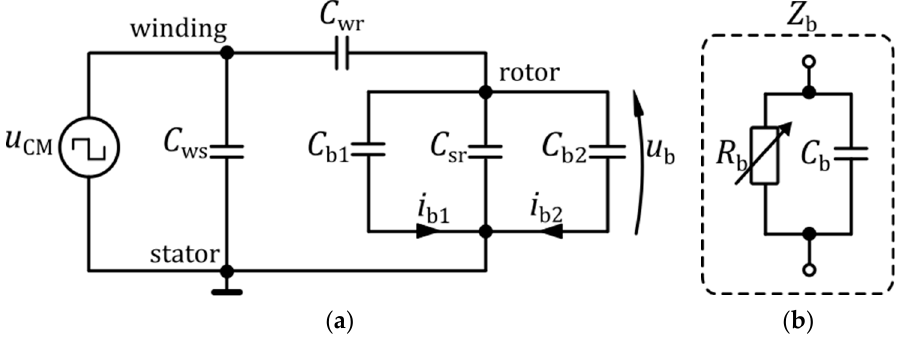
Figure 6. ( a ) Equivalent circuit diagram for the flow of the bearing current; u CM —common-mode voltage, u b —bearing voltage, description of other parameters in the text, ( b ) equivalent circuit of the bearing impedance Z b , composed of: bearing resistance R b and capacitance C b .